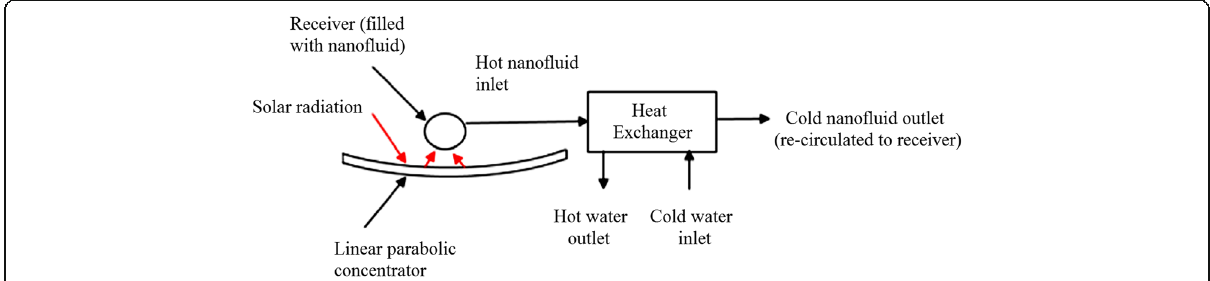
Fig. 6 Schematic of nanofluid-based concentrating solar water heating system. Redrawn based on reference